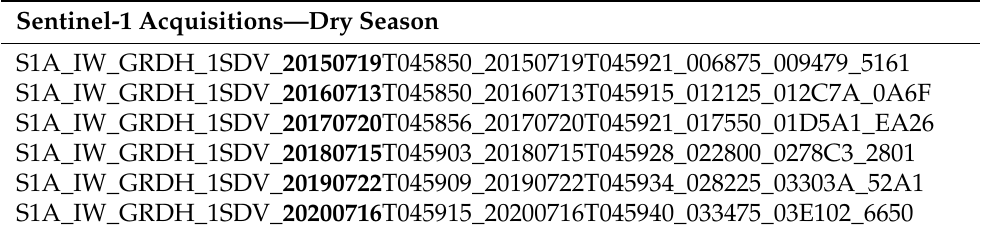
Table 3. SAR products downloaded from the Alaska Satellite Facility’s data portal (ASF DAAC). Dry season acquisition dates are highlighted in bold